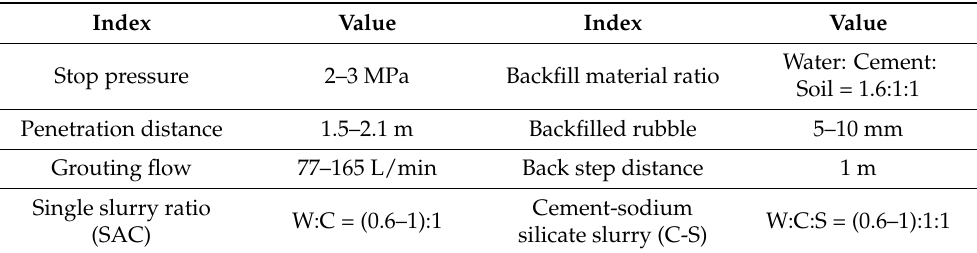
Table 3. Penetration grouting parameters.